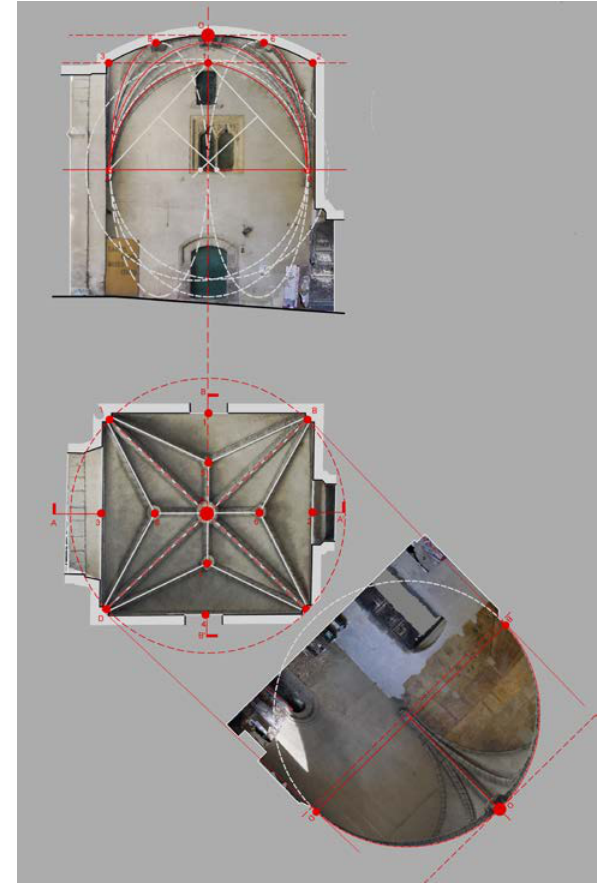
Figure 16 . Castel Nuovo five keystones vault in Naples: discover the geometric rules.